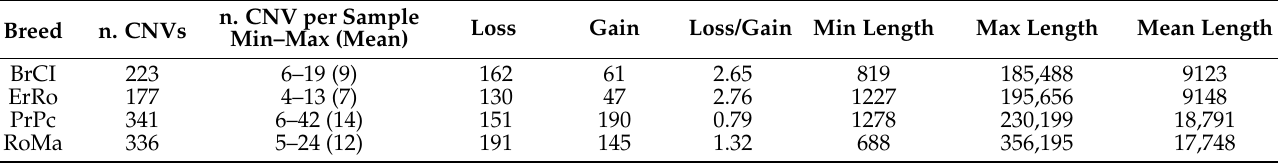
Table 2. Descriptive statistics of CNVs identified in each turkey Breed. CNV length are expressed in base pairs (bp). Breed n.